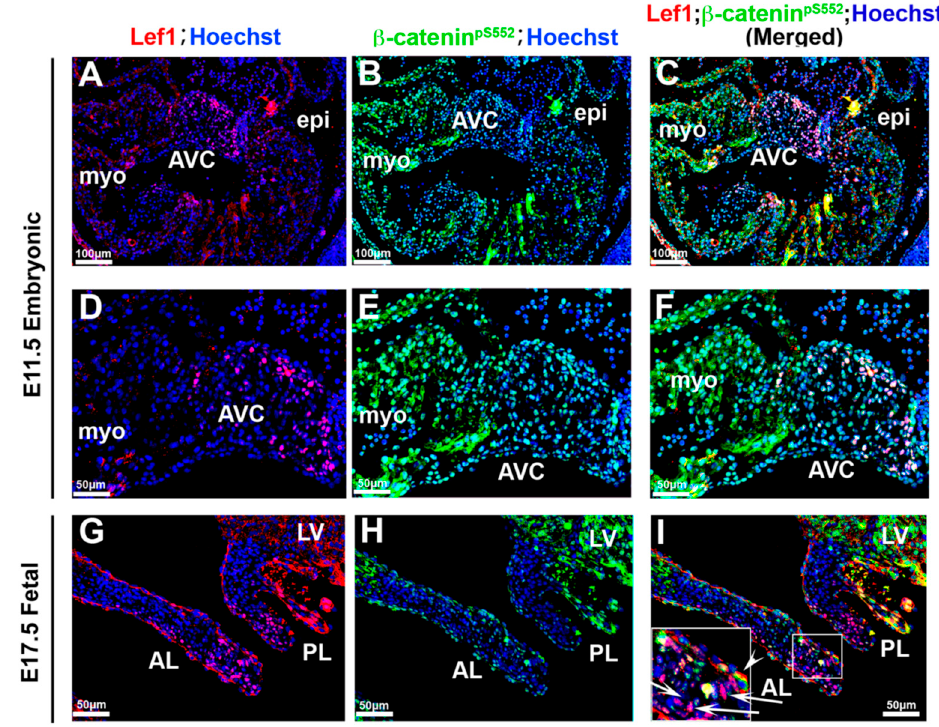
Figure 9. Correlation of β -catenin activities with Lef1 ( A – F ). Activated β -catenin (green) and Lef1 (red) were co-stained on E11.5 tissue. Only a subset of activated β -catenin positive cells were co-stained with Lef1. ( G – I ) Co-staining Lef1 with activated β -catenin at E17.5. Lef1 positive cells were localized to the tip of the leaflets showing no appreciable β -catenin staining (( G , I )—arrows) and valve endocardial cells that co-stained with both markers were rarely observed (( I )—arrowhead). AVC = atrioventricular cushions, myo = myocardium, epi = epicardium, AL = anterior leaflet, PL = posterior leaflet, LV = left ventricle.